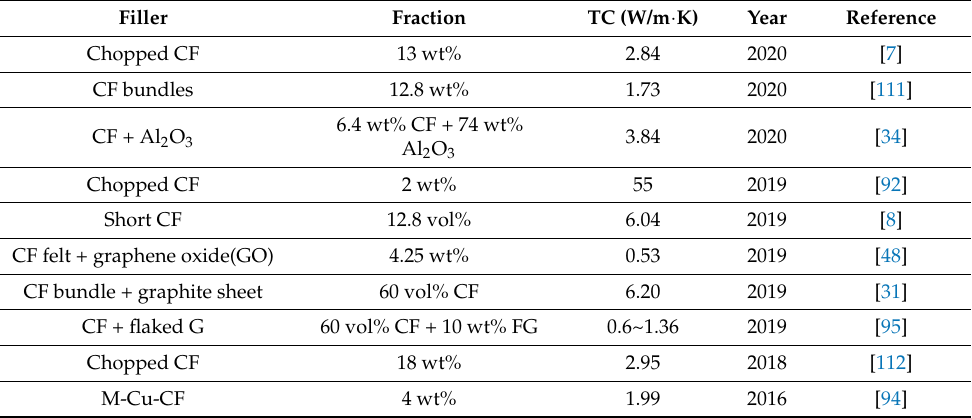
Table 1. Thermal conductivities of Carbon fiber based composites at different fractions reported in different published